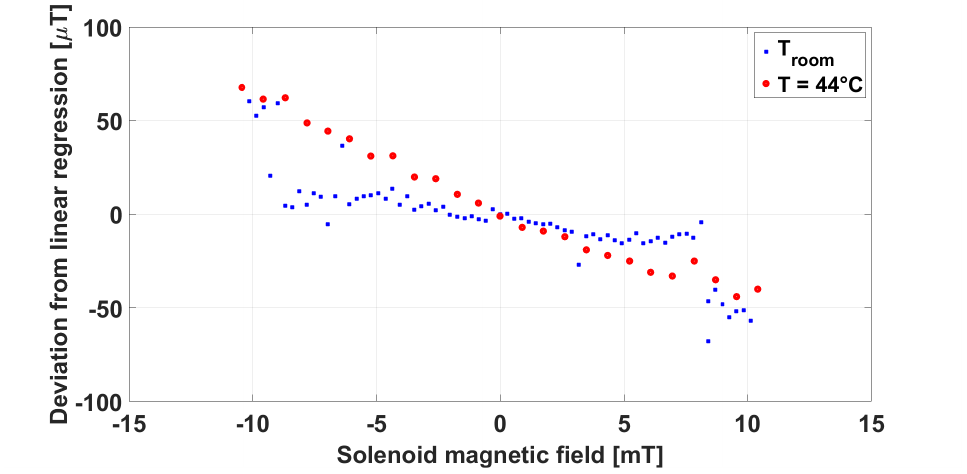
Figure 13. Comparison of linearity tests carried out at Consorzio RFX at room temperature and at 44 ◦